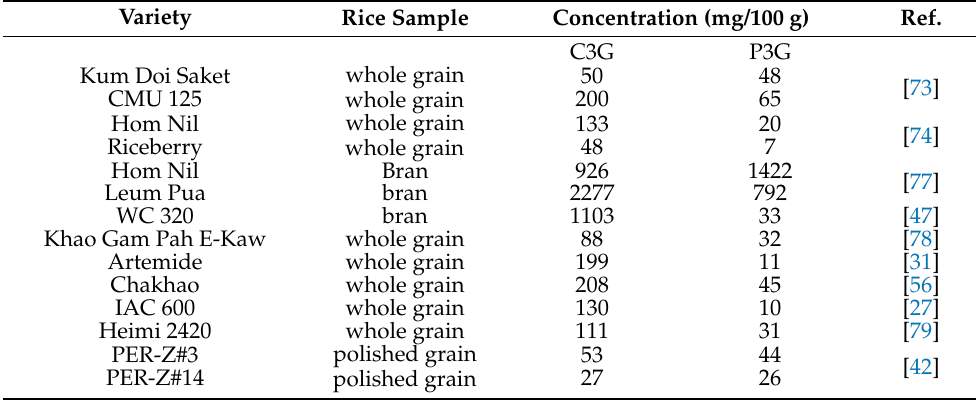
Table 3. Major anthocyanin species (cyanidin-3-glucoside; C3G and peonidin-3-glucoside; P3G) in various purple rice